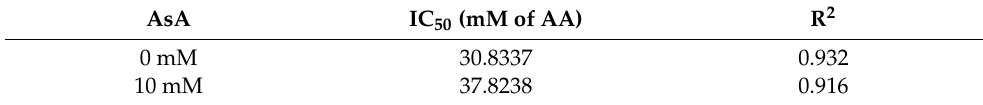
Table 1. IC 50 value indicating inhibitory concentration of AA to cell